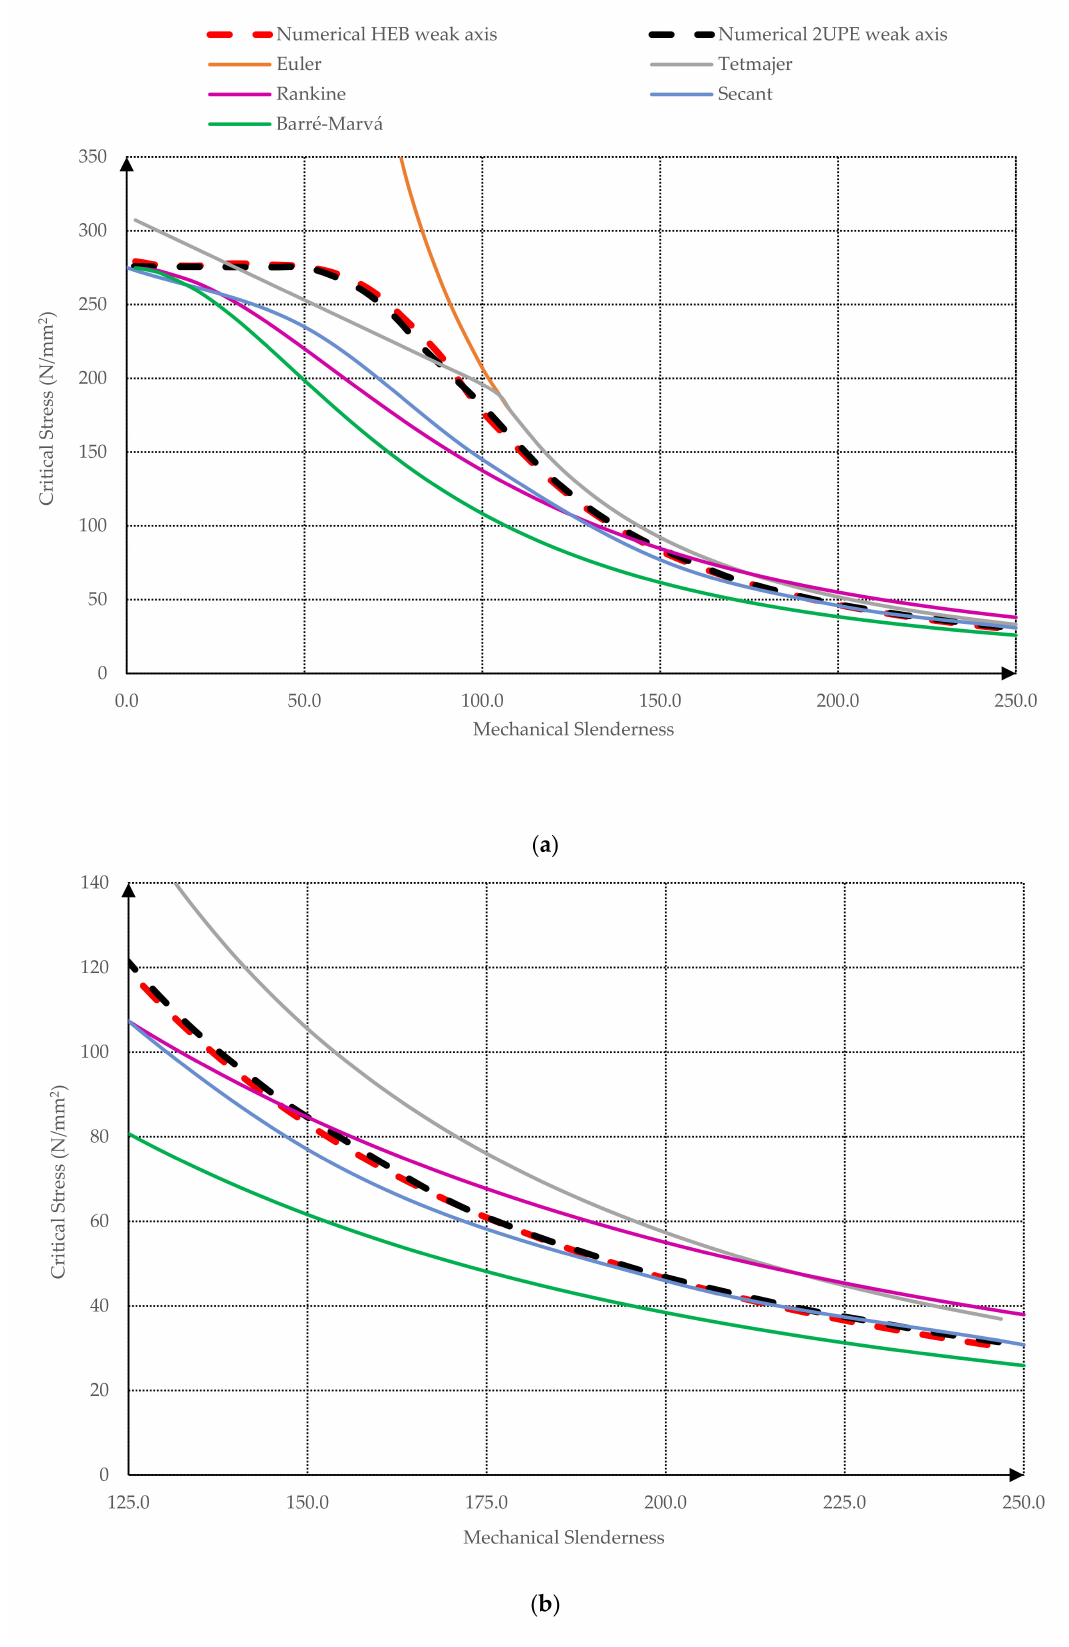
Figure 9. Strength–mechanical slenderness graph. Comparison theoretical models and numerical simulation: ( a ) mechanical slenderness from 0 to 250; ( b ) detail for high mechanical slenderness ratios (from 125 to